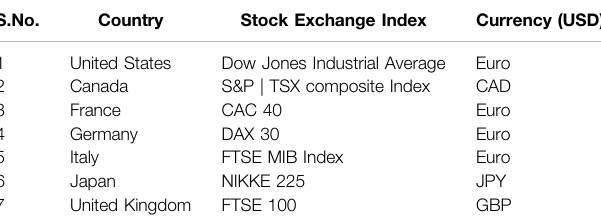
TABLE 2 | List of Forex and equity returns considered for G7 countries S.No.